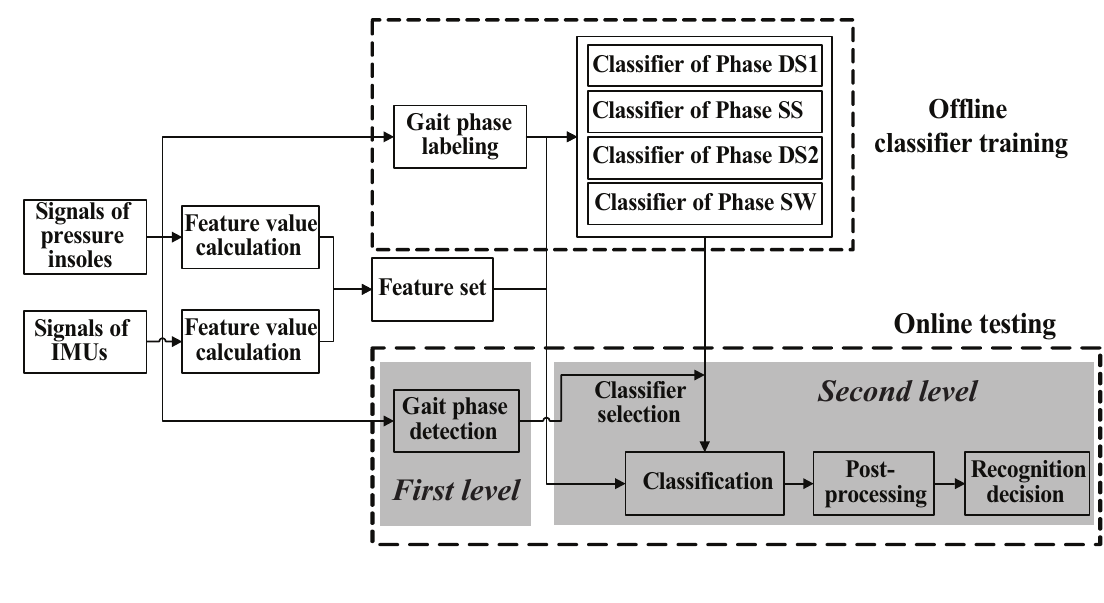
Figure 3. Block diagram of the locomotion intent prediction